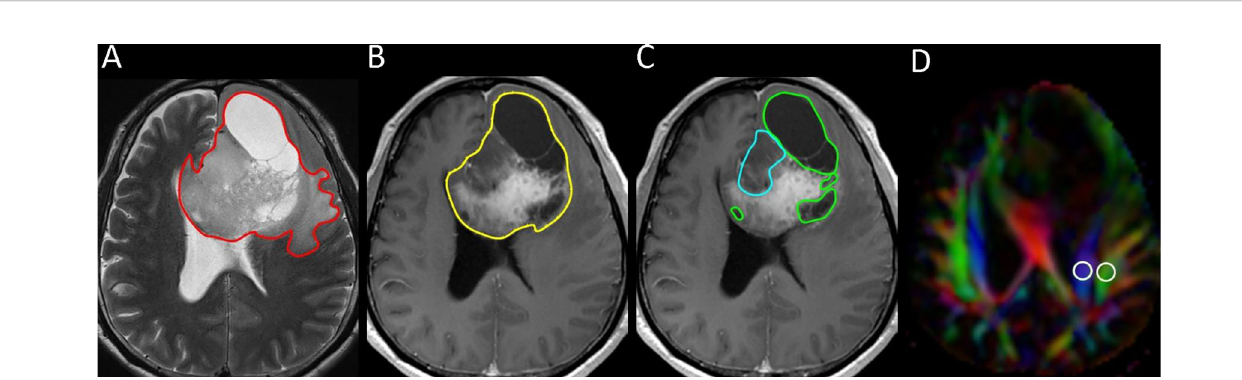
FIGURE 1 | Example of how regions of interest (ROIs) were segmented in a left frontal grade II glioma. (A) Transverse T2-weigthed image showing a manually drawn polygonal ROI ( red ) that includes the entire peritumoral brain edema and the whole tumor. (B, C) On contrast-enhanced T1-weighted images, the ROIs of whole tumor ( yellow ), non-enhancing tumor ( blue ), and necrotic portion ( green ) are shown. (D) Directionally encoded color map illustrating the ROIs of the projection ( blue area ) and association ( green area ) fi bers in the left periventricular region for calculation of the analysis along the perivascular space (ALPS)